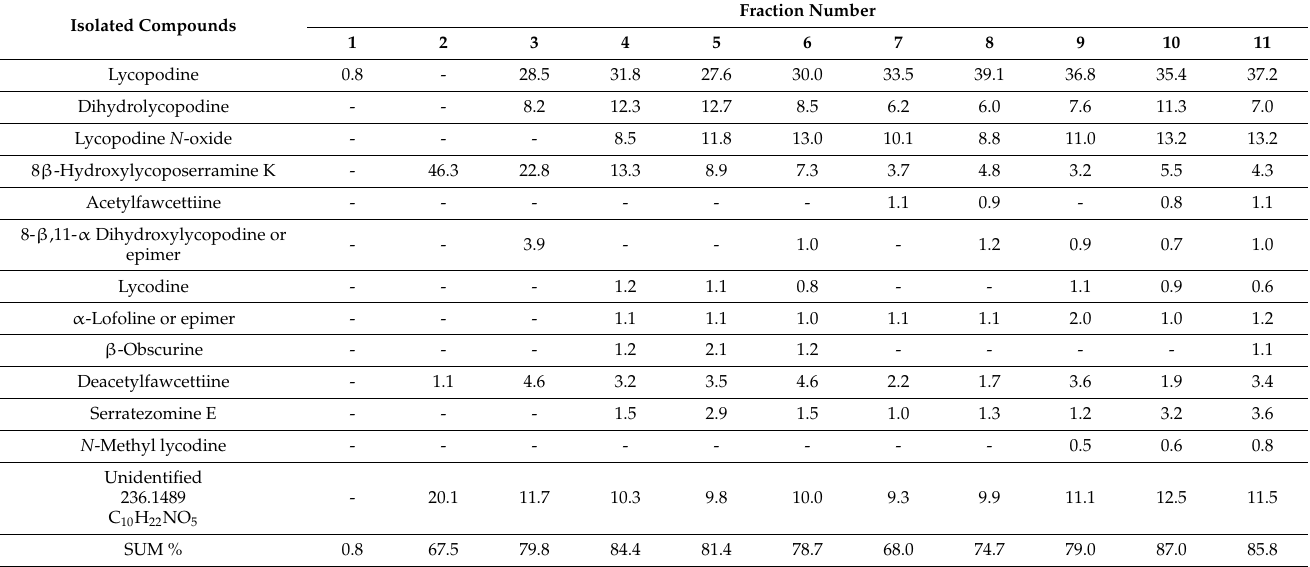
Table 10. Results of alkaloids identified via HPLC/ESI-QTOF-MS present in fractions 1–11 obtained from experiment 4 via VLC using silanized silica gel as a sorbent and reverse phase system from L. clavatum extract. Isolated